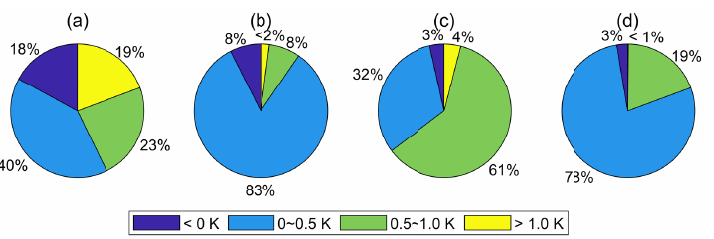
Figure 10. The statistics of RMSE reductions in ( a ) ENNTm-A w.r.t. GTrop-Tm; ( b ) ENNTm-B w.r.t. NN-II; ( c ) ENNTm-C w.r.t. NN-II; and ( d ) ENNTm-C w.r.t. ENNTm-B. w.r.t = with respect